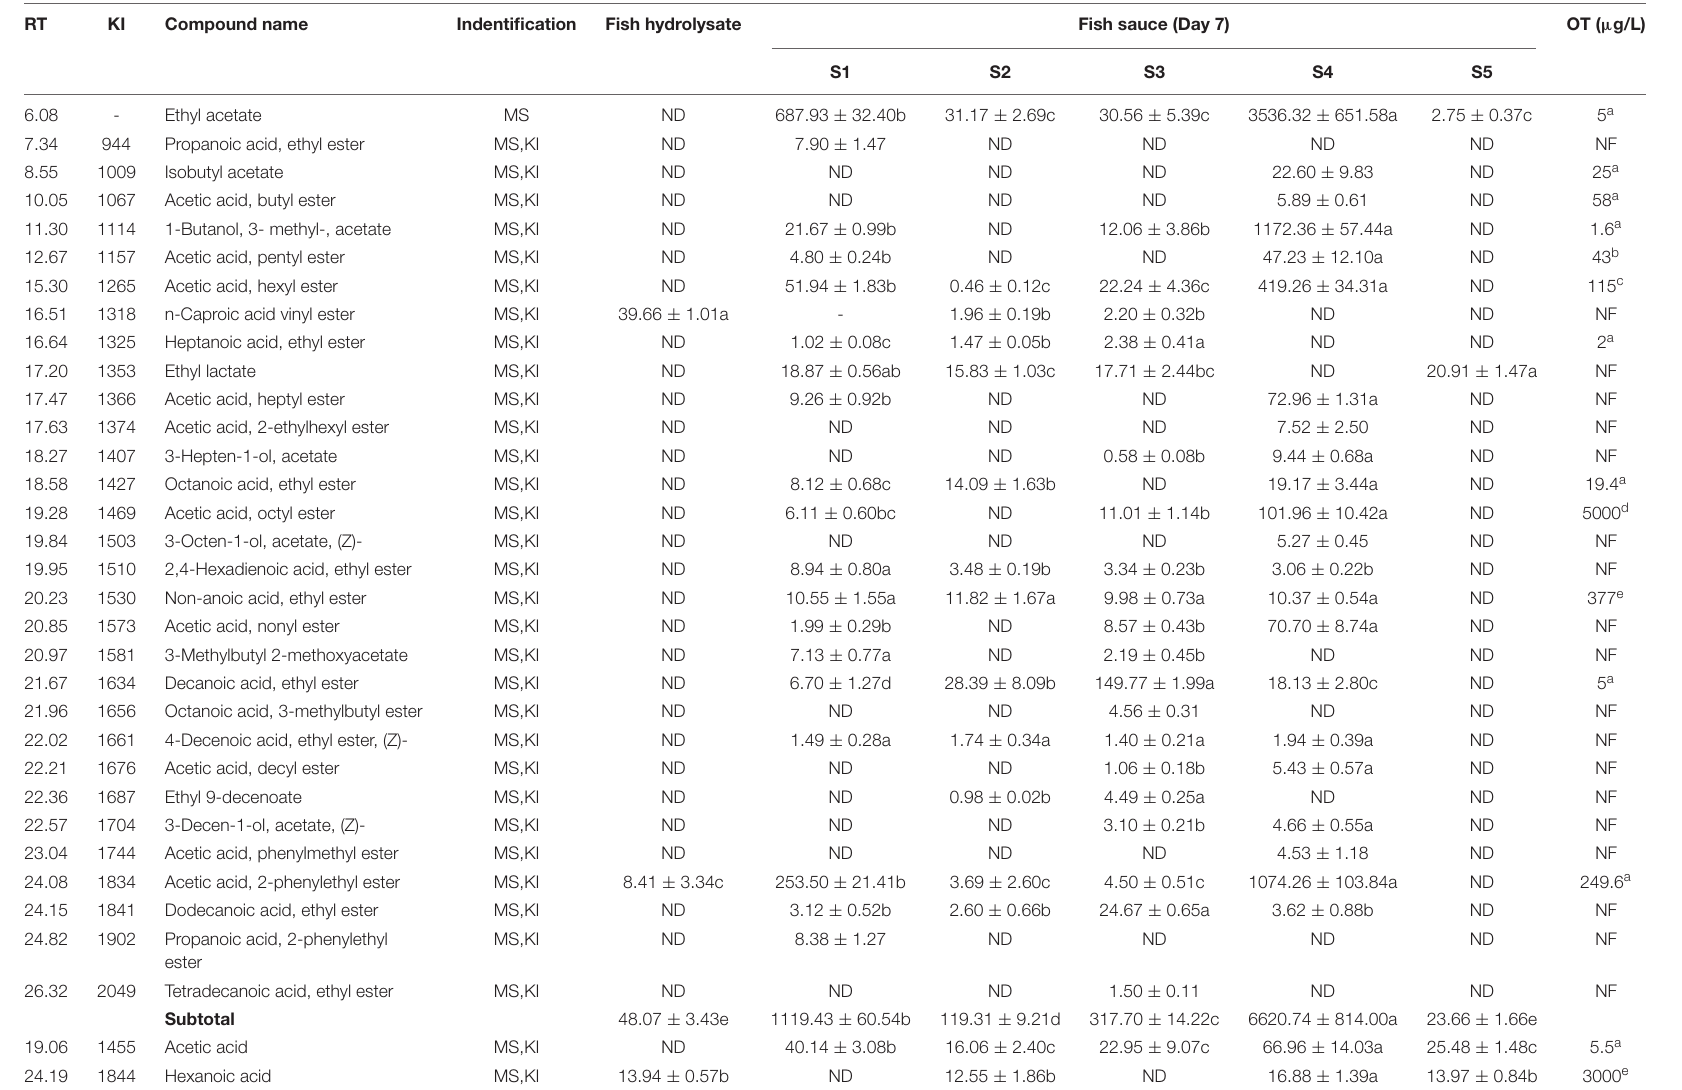
TABLE 2 | Volatile compounds in fish sauce fermented with different yeasts ( µ